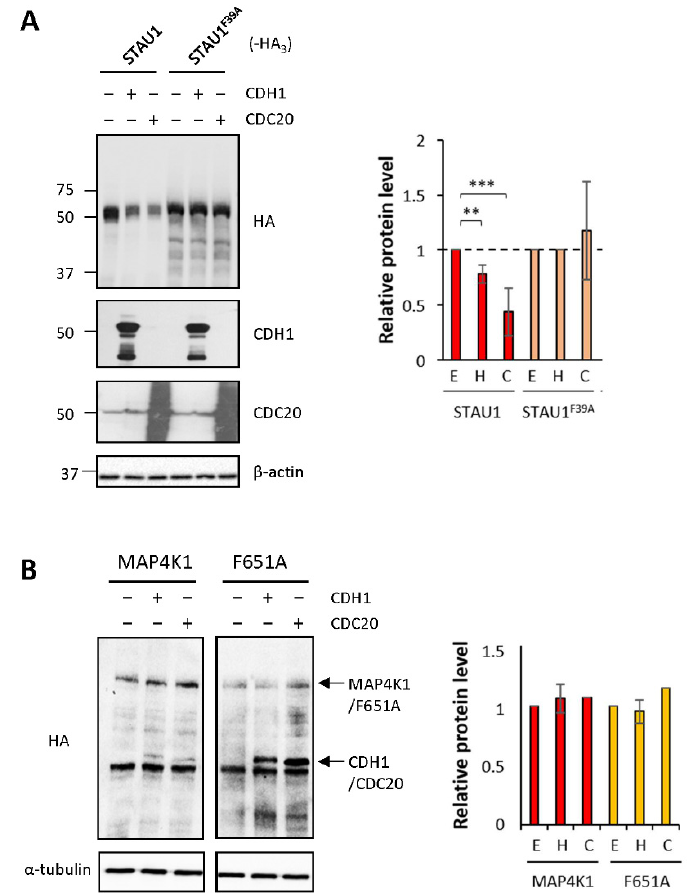
Figure 5. CDC20 and CDH1 recognize the FPL-motif of STAU1 55 but not of MAP4K1. HEK293T cells were cotransfected with plasmids coding for STAU1 55 -HA 3 , STAU1 F39A -HA 3 ( A ) , MAP4K1-HA 3 , or MAP4K1 F651A -HA 3 ( B ) and plasmids coding for CDC20 or CDH1. Protein extracts were analyzed by Western blotting using anti-HA antibody. The graphs on the right represent the means ± standard deviation of the relative amounts of the proteins in three independently performed experiments. The ratio of the amount of the proteins to that of actin ( A ) or tubulin ( B ) in the absence of cotransfected proteins was fixed to 1. ***, p -value ≤ 0.001. **, p -value ≤ 0.01 (Student t -test). NS, not significant. E, empty vector; H, CDH1; C,